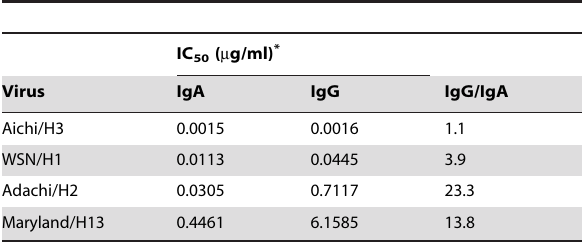
Table 3. Comparison of neutralizing activities of S139/1 IgA and IgG